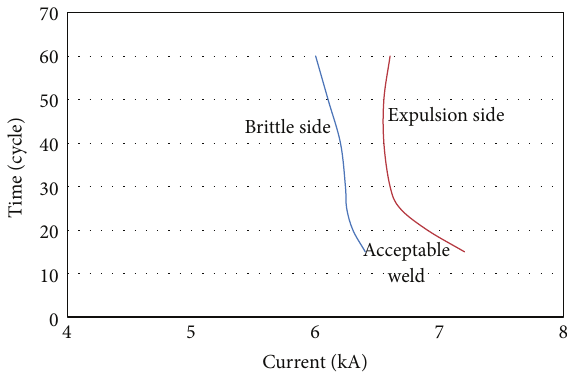
Figure 6: Lobe curve; 𝑑